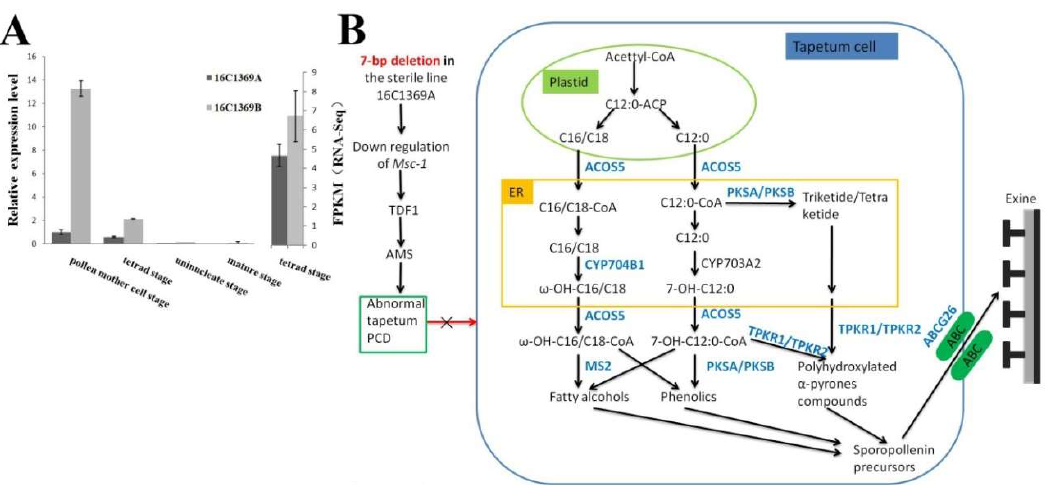
Figure 7. A possible gene regulation network in the male sterile line 16C1369A. ( A ) The expression pattern of Msc-1 detected in qRT-PCR and transcriptome. ( B ) A possible gene regulation network according to which abnormal tapetal programmed cell death (PCD) is triggered by the down-regulation of Msc-1 in the male sterile line 16C1369A.